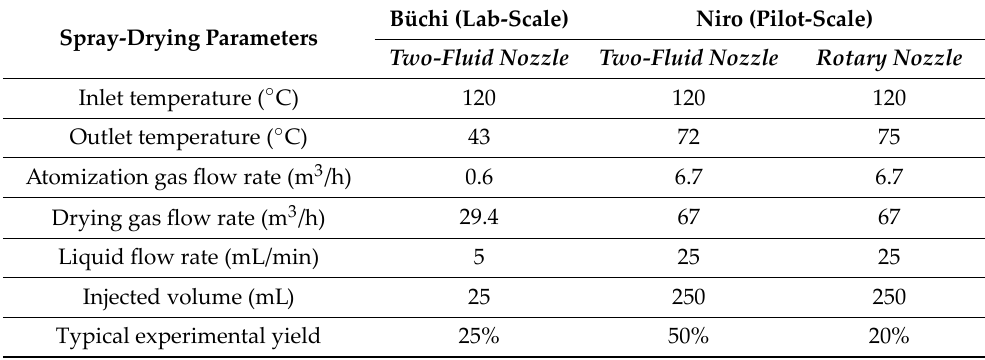
Table 2. Experimental parameters for the syntheses in the lab‑ and pilot‑scale spray dryers. Büchi (Lab‑Scale) Niro (Pilot‑Scale) Spray‑Drying Parameters Two‑Fluid Nozzle Two‑Fluid Nozzle ◦ Inlet temperature (